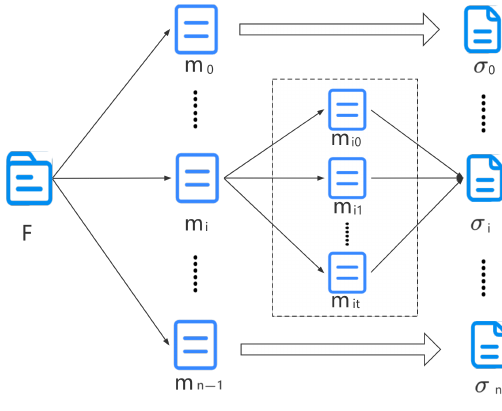
Figure 2. Mapping of data blocks and